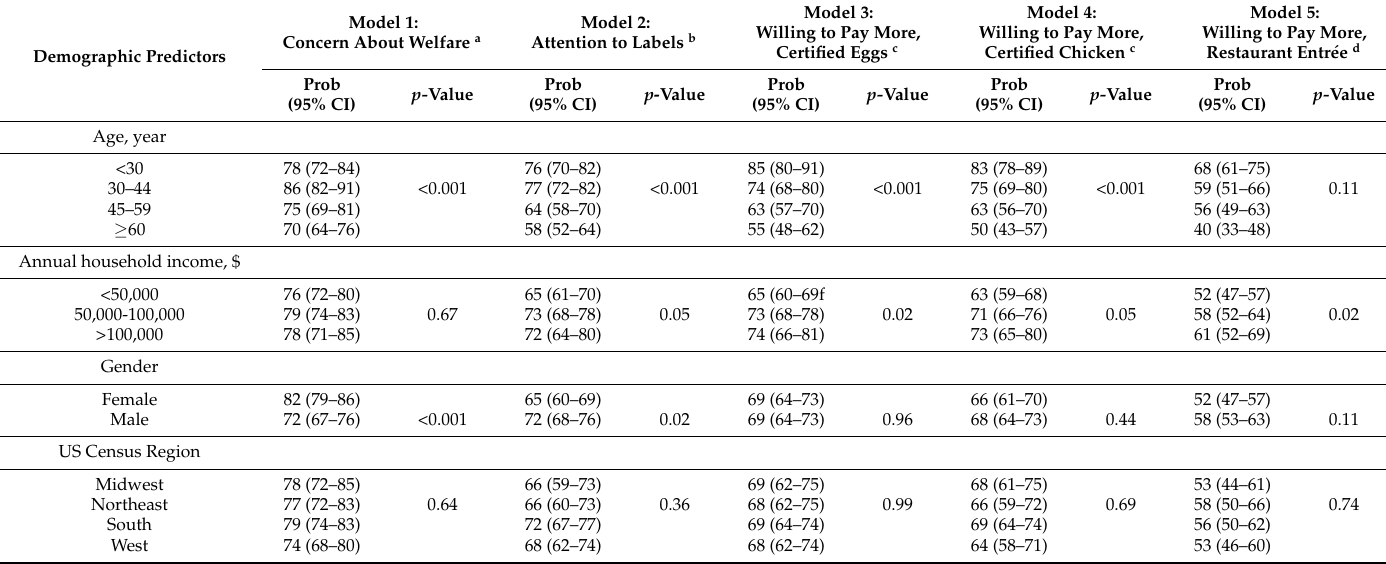
Table 5. Modeled probabilities of five outcomes related to attitudes toward farm animal welfare and reported willingness to pay for higher welfare products by four key demographic